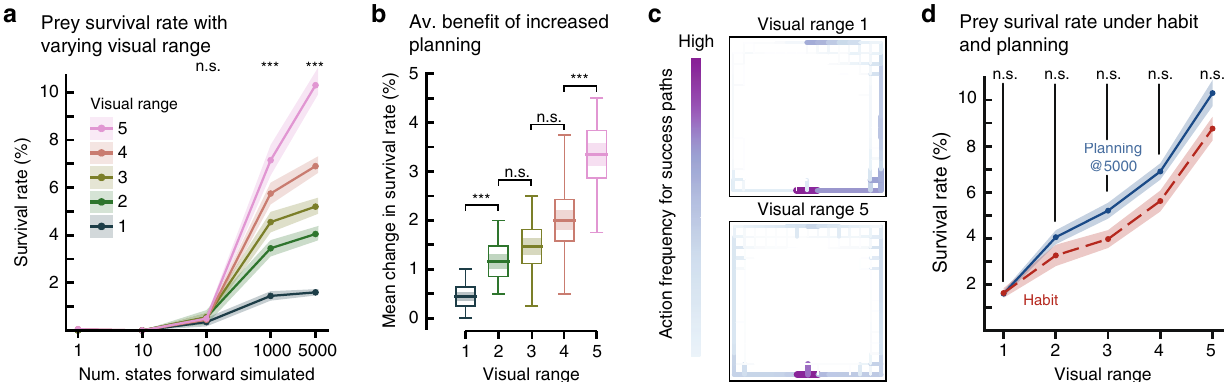
Fig. 2 The utility of different behavioral controllers in open environments. a Prey survival rate in pseudo-aquatic environments (Fig. 1a). The line plot shows the mean survival rate, and the surrounding fi ll indicates ±s.e.m across random initial predator locations ( n = 20). Two-tailed Kruskal – Wallis (KW) test: H 100 = 2.0, p = 0.57; H 1000 = 55.5, p < 10 − 10 ; H 5000 = 81.3, p < 10 − 16 . b Mean change in survival rate across all the planning levels shown in ( a ) (see Methods). Horizontal line: mean; Shaded region: ±s.e.m; Box: 95% con fi dence interval of the mean; Vertical line: range of the data. n = 20